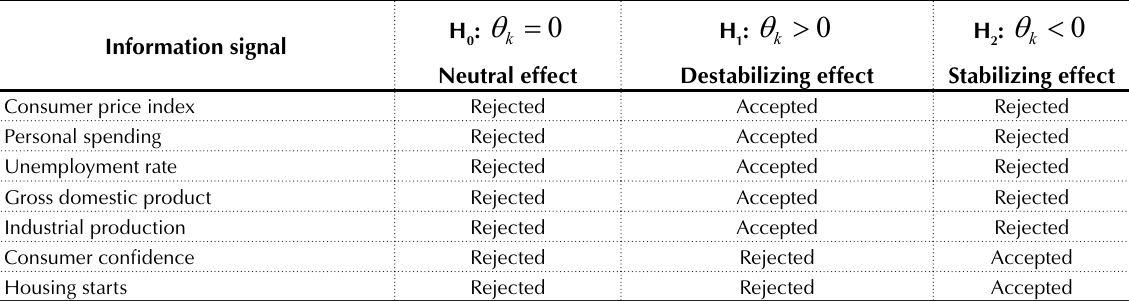
Table 12. The results of testing the hypotheses H component of the “surprise” of non-monetary information signals on stock quotes of enterprises of the economic sector